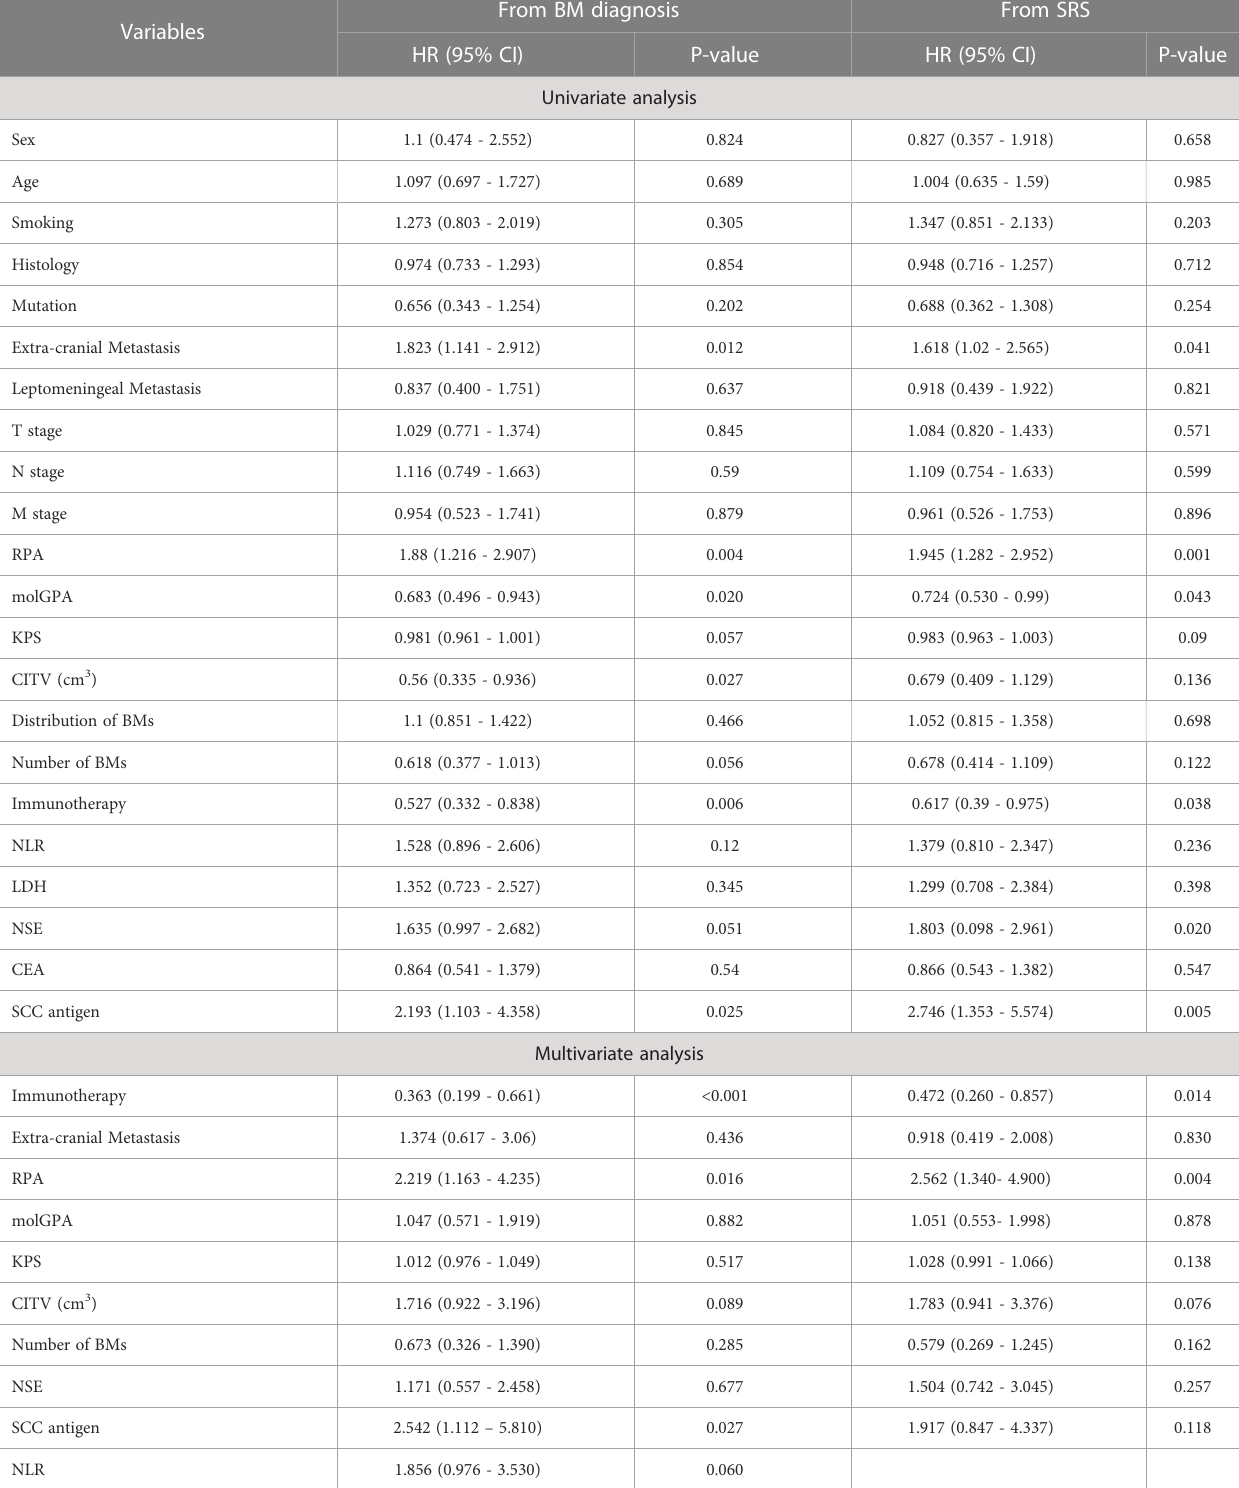
TABLE 2 Univariate and multivariate analysis for overall